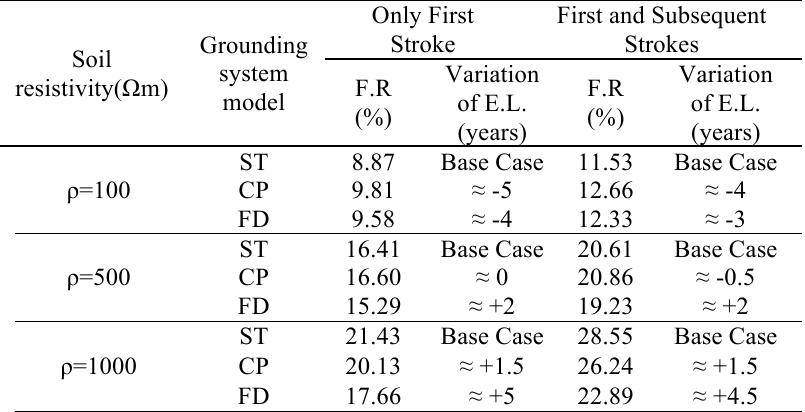
Table 10: Insulation Failure Risk (F.R.) for Different Modelling of Grid-shape Grounding System, (N g